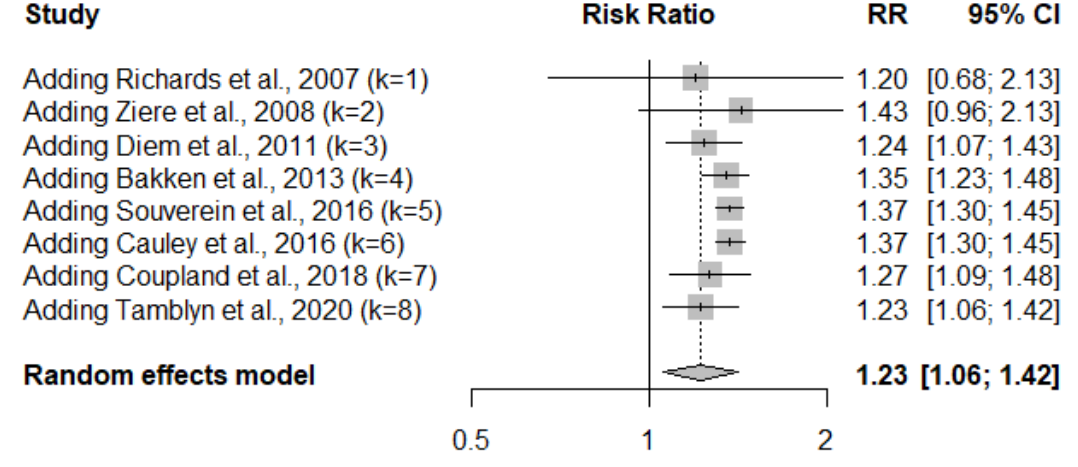
Figure 3. Cumulative random-effects meta-analysis of TCA effects on the risk of fracture. The DerSimonian − Laird method was used for analysis.